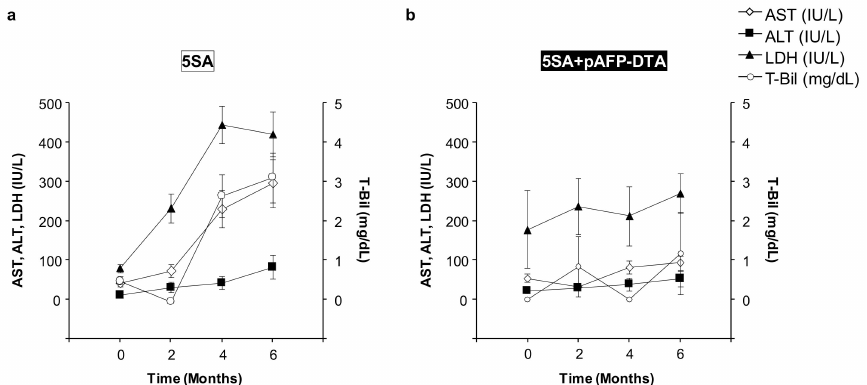
Figure 6. Time-dependent course of serum biochemical factors. Serum concentrations of aspartate transaminase (AST), alanine aminotransferase (ALT), lactate dehydrogenase (LDH), and total bilirubin (T-Bil) in ( a ) mice delivered with YAP-expressing plasmid (5SA) and ( b ) mice treated with pAFP–DTA just after the delivery of 5SA. The values represent mean ± standard deviation ( n = 3 for each